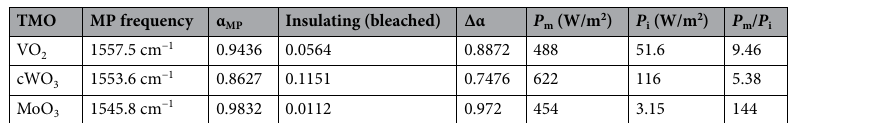
Table 1. Absorptance difference and emissive power ratio of TMO